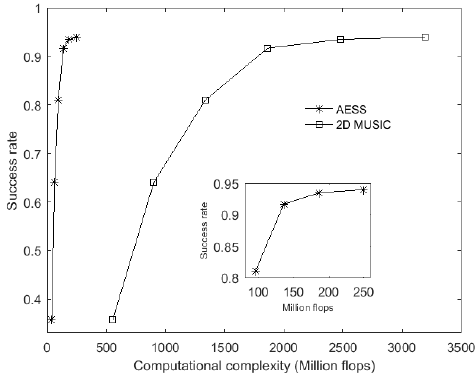
Figure 6. Success rate versus computational complexity.